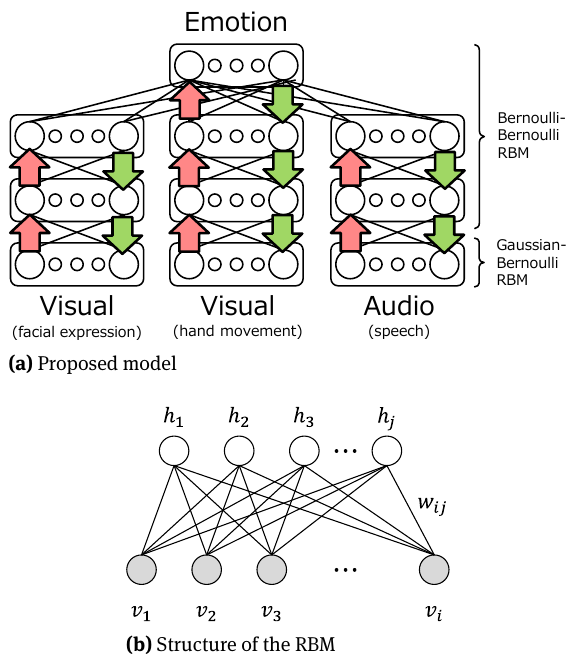
Figure 2: Overview of our proposed model and the structure of the RBM: (a) Each two layers connected black lines represents the RBM. The red arrows signify forward sampling (estimation of the partners’ emotion) and the green arrows signify backward sampling (gen- eration of own emotional expressions). (b) v i and h j indicate the i -th visible unit and the j -th hidden unit, respectively, and w ij is the connection weight between those